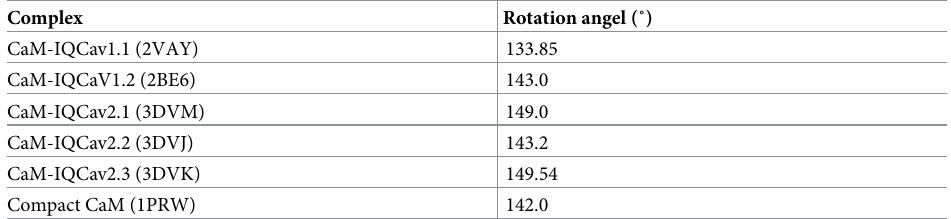
Table 1. Rotation angles of CaM C-lobes in various reported compact Ca 2+ /CaM-IQ motif complexes